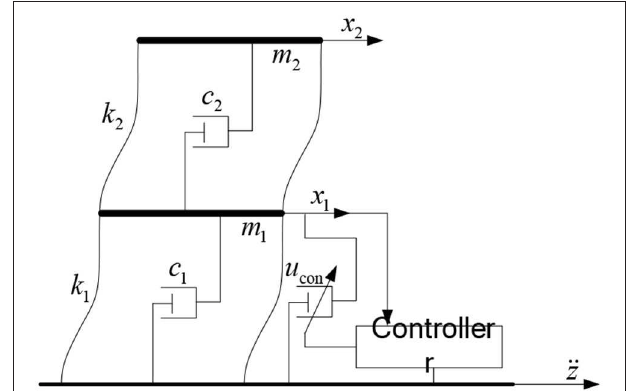
FIGURE 1 | The scaled 2-DOF building